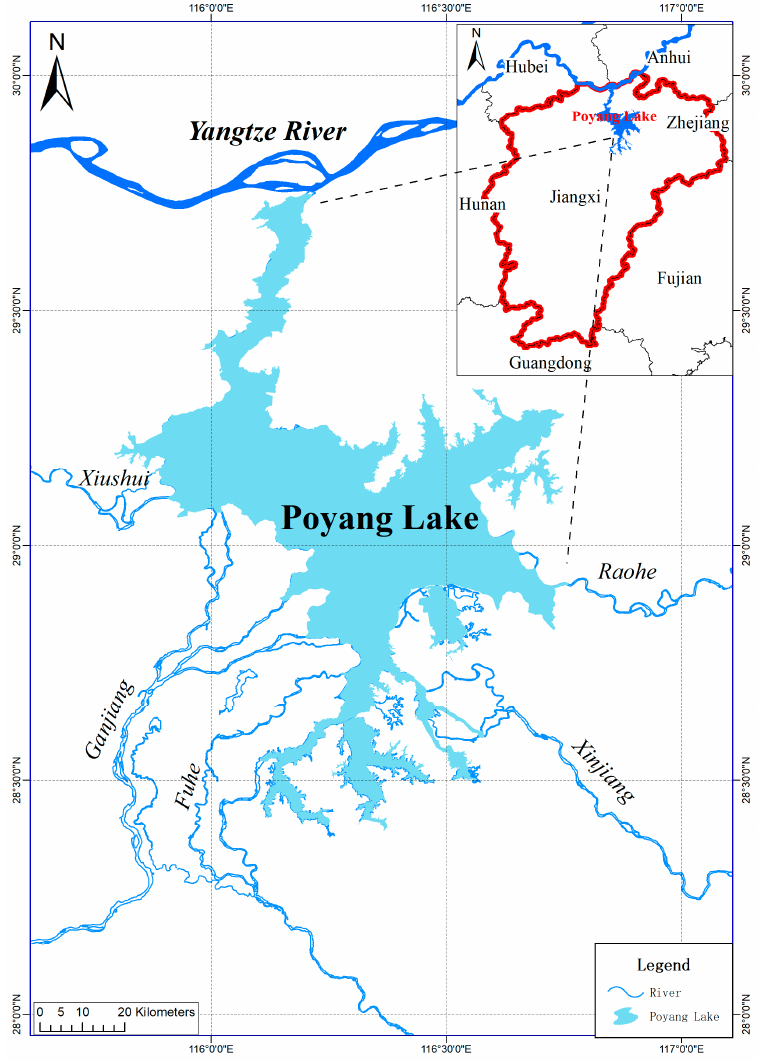
Figure 1. Poyang Lake location map.